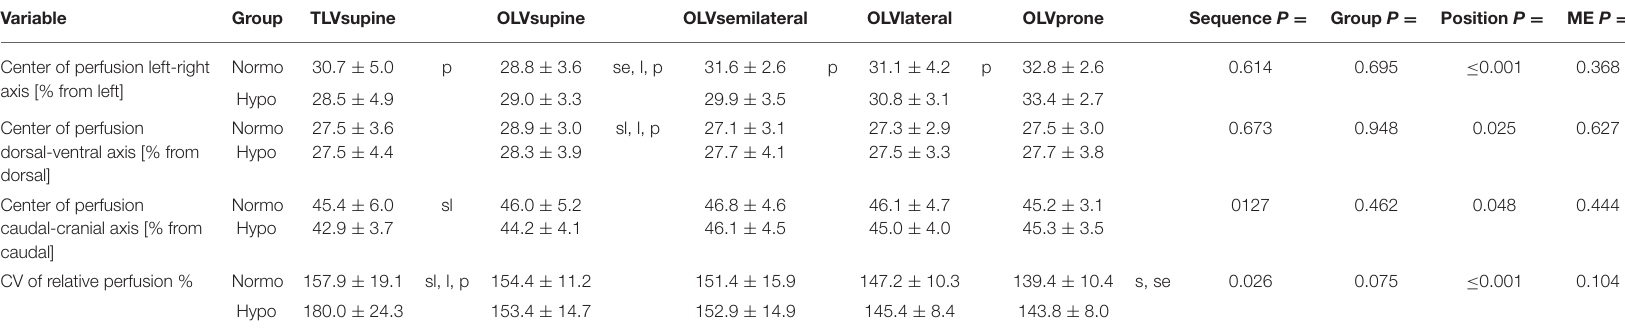
TABLE 2 | Perfusion of the left lung. Variable Group TLVsupine OLVsupine OLVsemilateral OLVlateral OLVprone Sequence P = Group P = Position P = ME P = Center of perfusion left-right axis [% from left] Center of perfusion dorsal-ventral axis [% from dorsal]